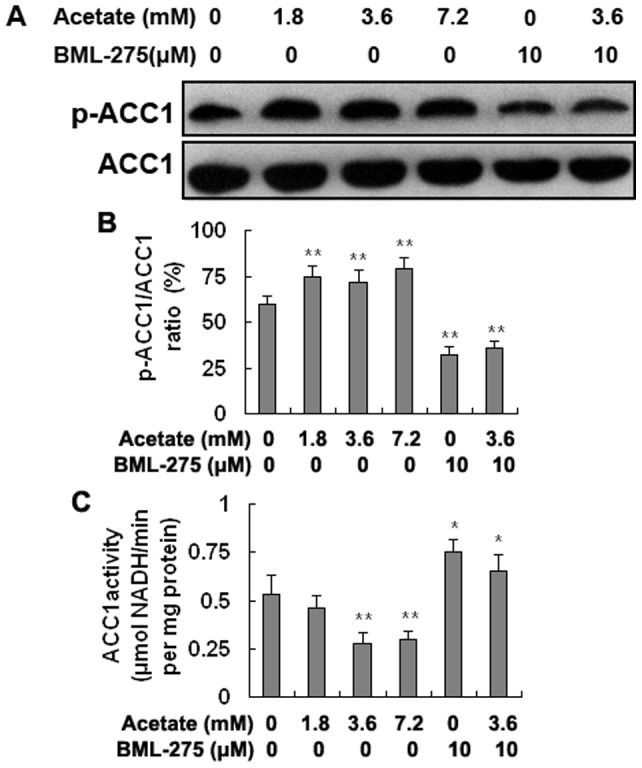
The phosphorylation level and enzyme activity of ACC1.Hepatocytes were treated with acetate and BML-275 and divided into a control group (0 mM acetate), a low-dose acetate treatment group (1.8 mM acetate), a medium-dose acetate treatment group (3.6 mM acetate), a high-dose acetate treatment group (7.2 mM acetate), a BML-275 group (10 μM BML-275), and a BML-275+acetate group (10 μM BML-275+3.6 mM acetate). Acetate (sodium acetate) was used in the form of neutralized acetic acid to avoid changing the pH of the medium. A: Western blotting results for p-ACC1 and ACC1. B: The phosphorylation level of ACC1. C: Enzyme activity of ACC1. * p<0.05, ** p<0.01 versus the control group.